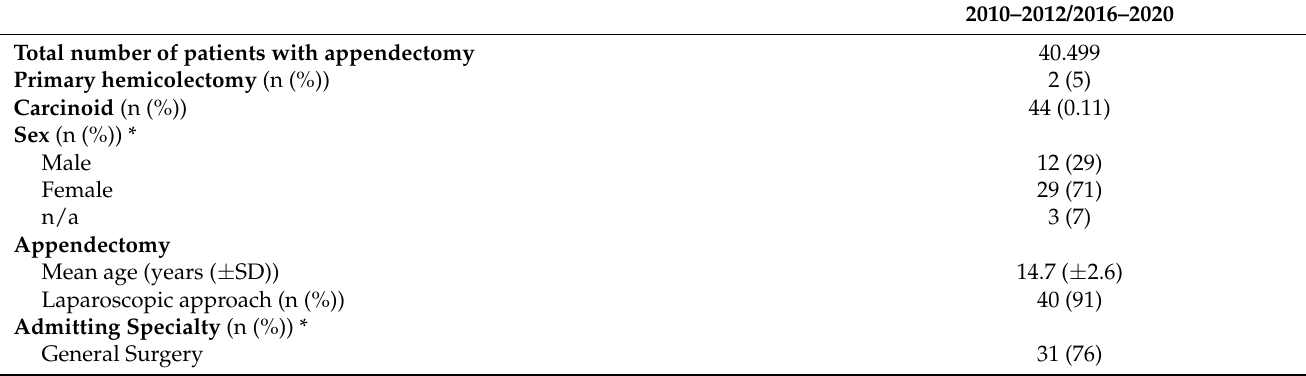
Table 1. Patient